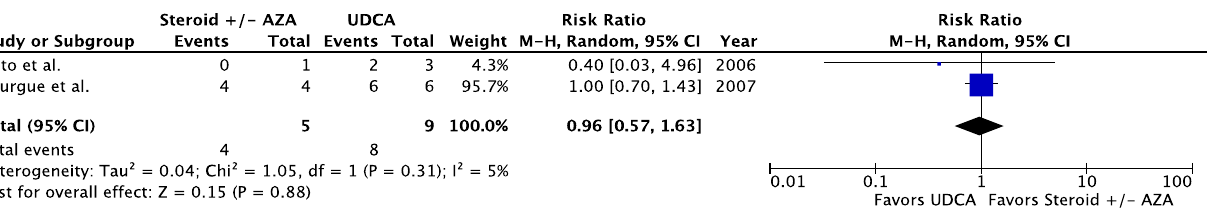
Figure 5. Biochemical improvement in AIH-PBC patients treated with immunosuppression vs. UDCA. UDCA = ursodeoxycholic acid, steroid = corticosteroids, AZA = azathioprine.